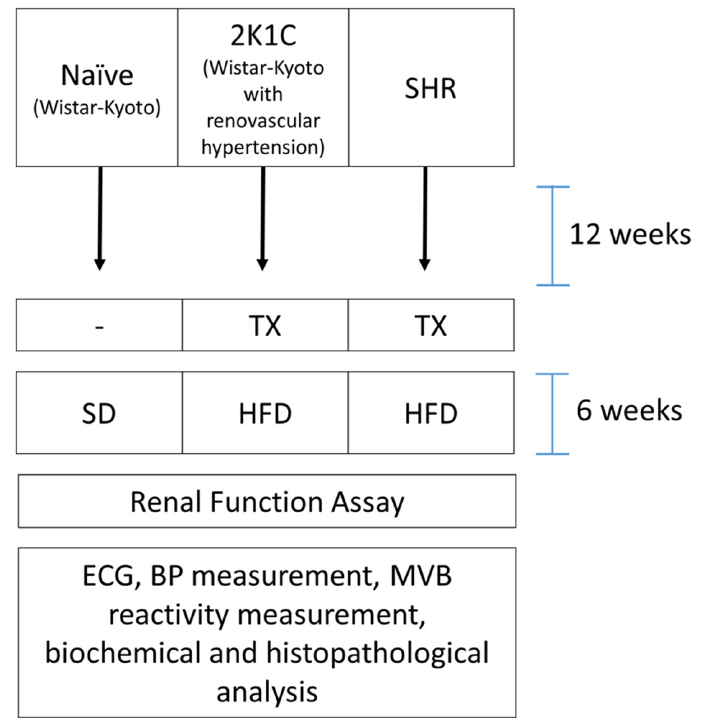
Figure 4. Experimental design: 2K1C: two-kidney-one-clip; HFD: high-fat diet; BP: body pressure; ECG: electrocardiography; MVB: mesenteric vascular bed; SHR: spontaneously hypertensive rats; TX: thyroidectomy.